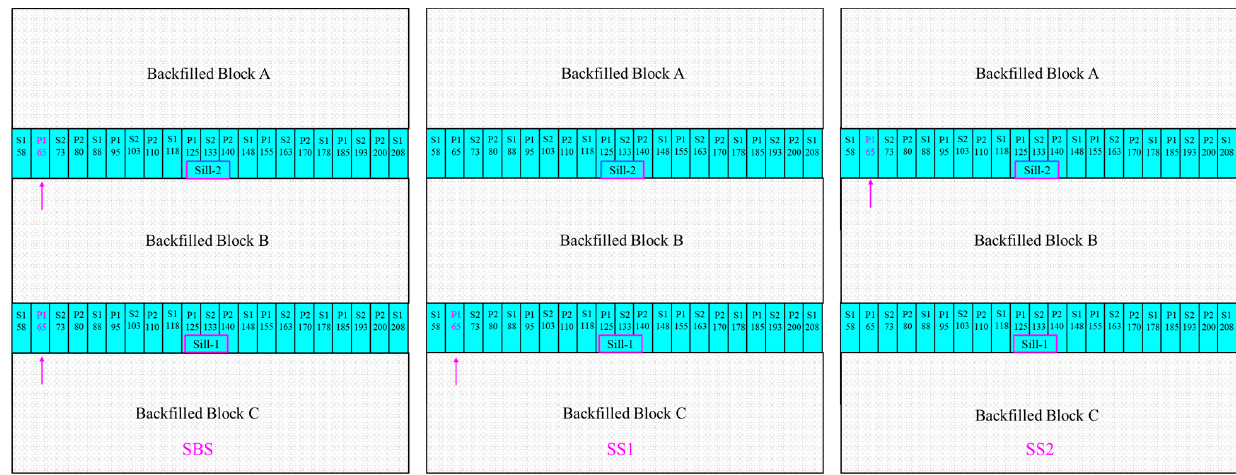
Figure 5. Profile of the sill pillar recovery scheme of SBS, SS1, and SS2.